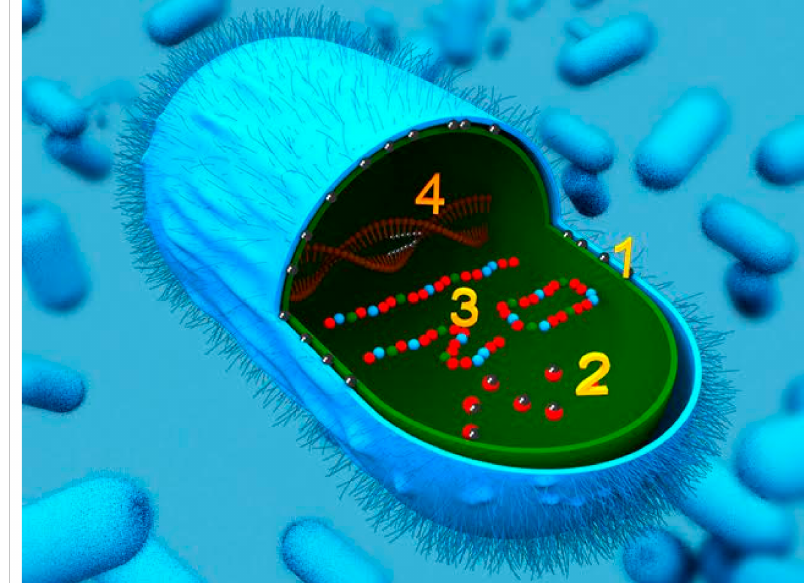
Figure 1. Silver’s action on a bacterial cell. 1. Silver can perforate the peptidoglycan cell wall. 2. Silver inhibits the cell respiration cycle. 3. Metabolic pathways are also inhibited when in contact with silver. 4. Replication cycle of the cell is disrupted by silver particles via interaction with